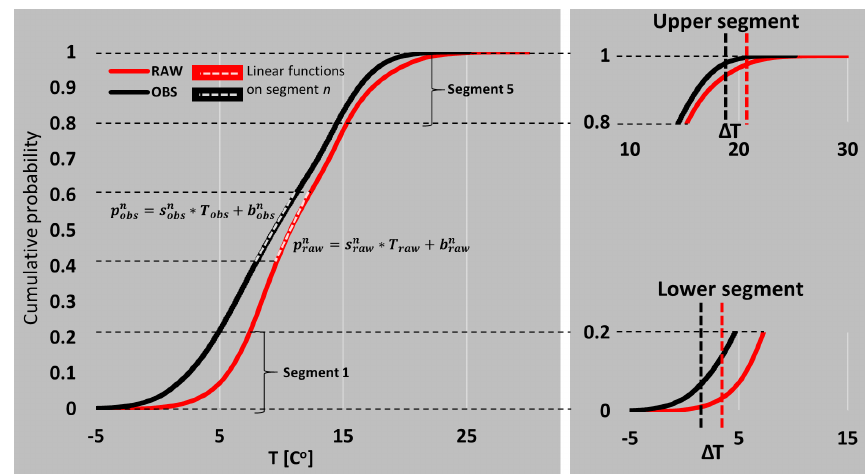
Figure 2. MSBC methodology on temperature correction using linear functions (borrowed from Grillakis et al., 2013; modified) in one of the data